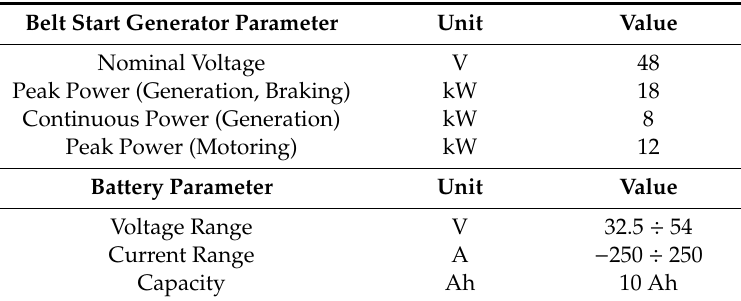
Table 4. Specifications of Belt Starter Generator and 48 V Battery.